Question: In one sentence, what is this figure communicating?
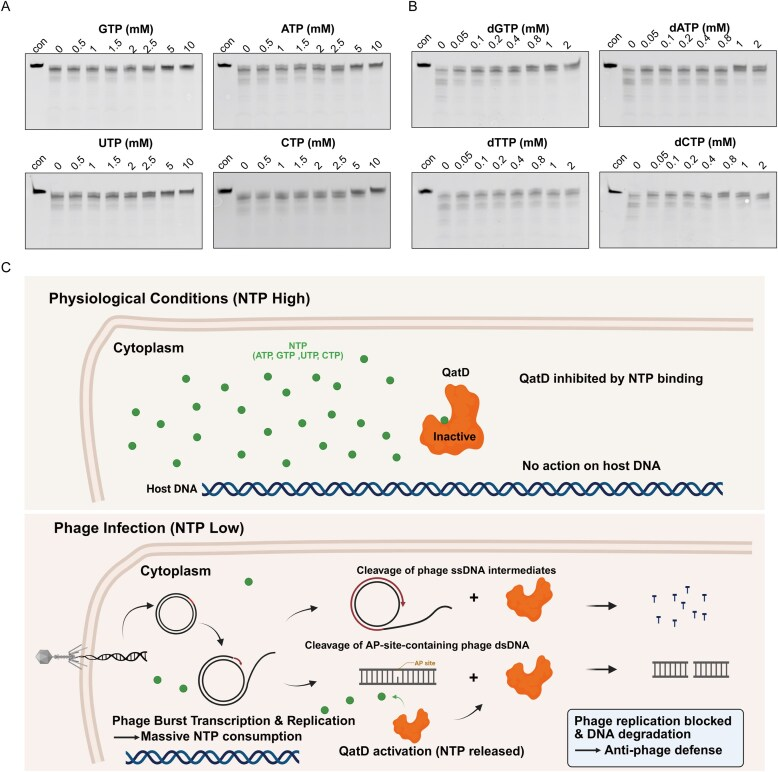
Answer: QatD exonuclease activity is inhibited by NTPs but not dNTPs. ( A ) The exonuclease activity of QatD was assayed using a 5′-FAM-labeled ssDNA substrate. Reactions containing 0.5 μM QatD and 0.1 μM substrate in the presence of 10 mM Mg 2+ were incubated at 37°C for 20 min, supplemented with the indicated concentrations of each NTPs (0–10 mM). Each assay was conducted in triplicate. ( B ) The exonuclease activity of QatD was assayed using a 5′-FAM-labeled ssDNA substrate. Reactions containing 0.5 μM QatD and 0.1 μM substrate in the presence of 10 mM Mg 2+ were incubated at 37°C for 30 min, supplemented with the indicated concentrations of each dNTPs (0–2 mM). All assays were performed in three independent replicates. ( C ) Model of NTP–dependent regulation of QatD anti–phage activity. High cellular NTP keep QatD inactive; phage–induced NTP depletion activates QatD to degrade phage DNA and inhibit phage propagation.